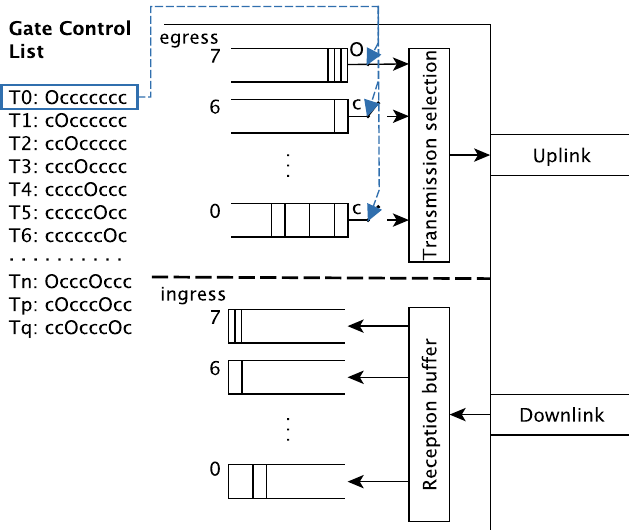
Figure 2. Internal structure of a port with Time-Aware Shaper. Each egress queue of the port has a gate that can be configured as open “O”, to allow frames to be transmitted, or closed “c”, to prevent frames from being transmitted. On the left-hand side of the figure we can see an example of gate control